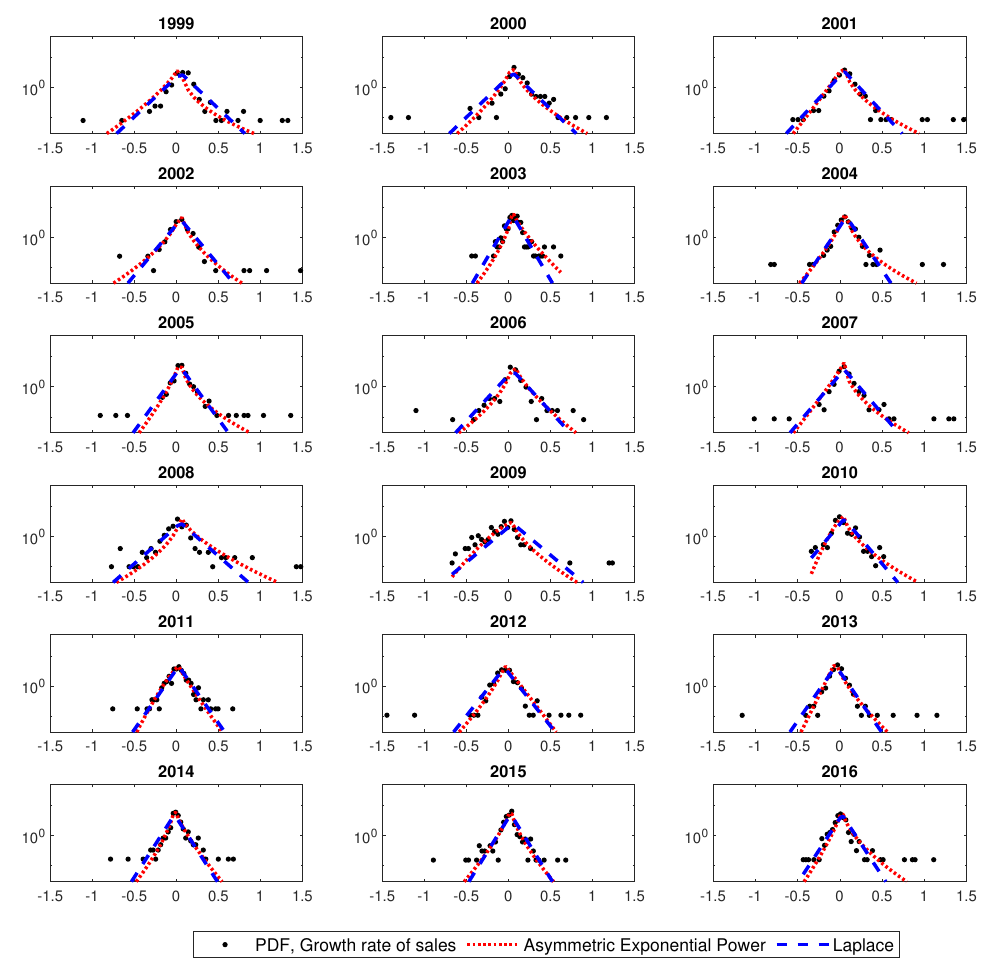
Figure A3. Probability Density Function (PDF) of growth rates of sales along with the AEP (dotted line) and Laplace (dashed line) distribution. The results refer to the 200 largest long-lived firms according to their sales in